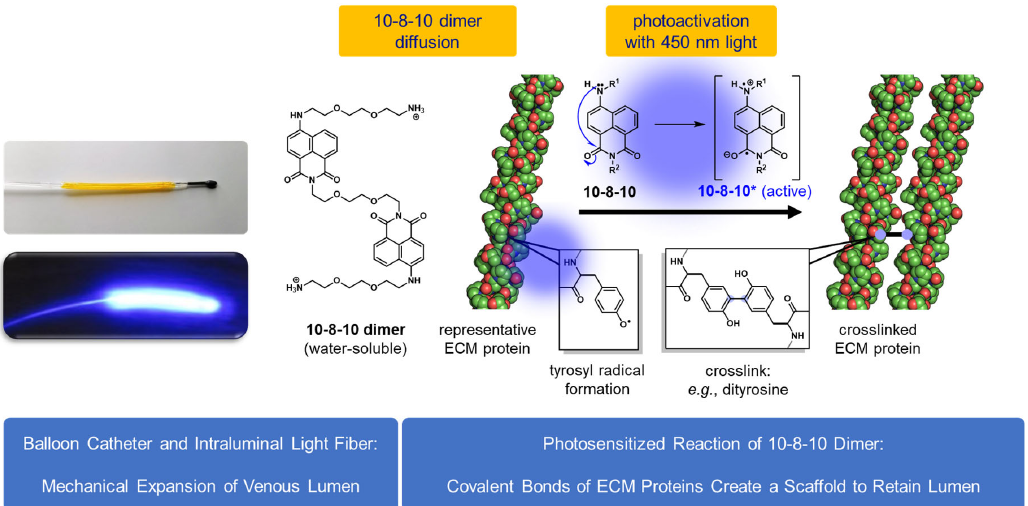
Figure 1. Mechanism of Action of the VRS-AVF Treatment. The Vascular Restoration System (VRS) delivers a photoactivatable small molecule (10-8-10 Dimer) to the vein using an intraluminally introduced balloon during surgery prior to arteriovenous fistula (AVF) creation. Light activation of the molecule with a 450 nm light at the time of balloon distension of the vein results in a photochemical reaction, facilitating new covalent bound formation among oxidizable amino acids of the extracellu- lar matrix (ECM) in the vein wall at the site of the balloon. Creating this natural vascular scaffold around the extended lumen aims to mitigate the hemodynamic stress but allow outward smooth